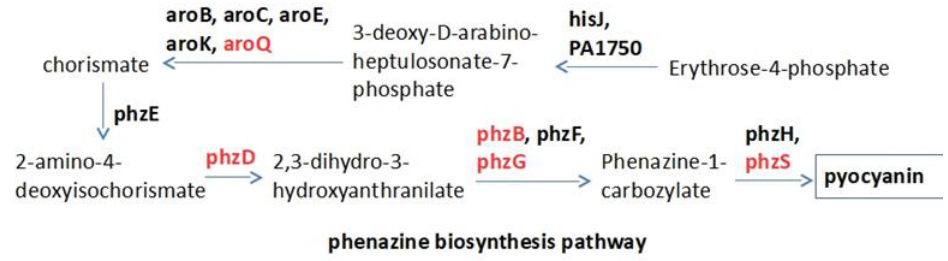
Figure1. Thephenazinebiosynthesispathway. Redindicatestheproteinswithknowncrystalstructures. Figure 1. The phenazine biosynthesis pathway. Red indicates the proteins with known crystal structures.